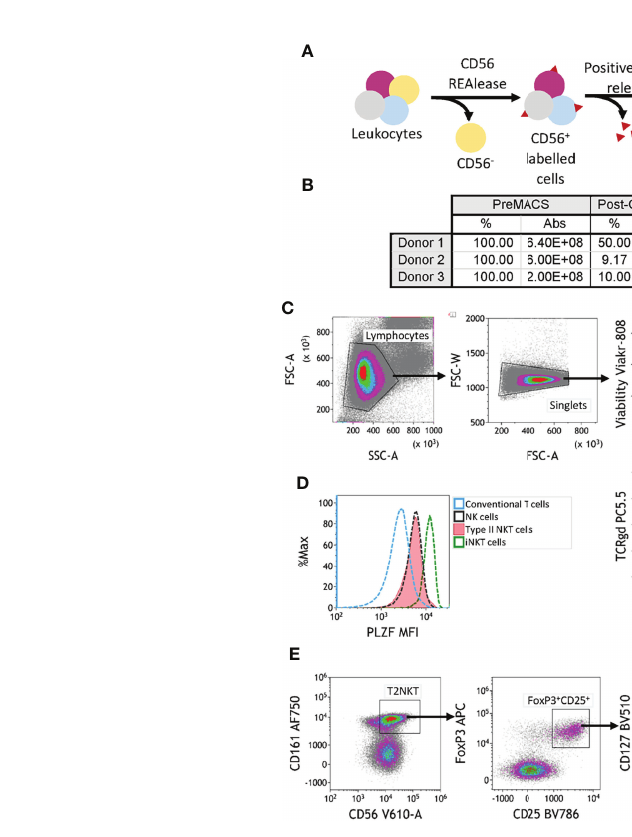
FIGURE 2 | Two-step magnetic-activated cell sorting (MACS) strategy for enrichment of human T2NKT cells. ( A ) Two-step MACS strategy consisted fi rst in a CD56 positive selection from human PBMC with CD56 REAlease microbeads. These beads were then detached from the cell surface after separation. In the second step, NKT cells were enriched using CD3 microbeads. The outcome of this procedure was a CD3 + CD56 + cell isolate enriched in NKT cells. (B) Summary table indicating the frequency of cells relative to preMACS values and absolute (Abs) cell numbers after each MACS step. (C) Gating of human leucocytes enriched for CD56 + CD3 + cells using the two-step MACS protocol. The sample was enriched for iNKT cells (2% of total CD3 + T cells) and T2NKT cells (5.3% of total CD3 + T cells). (D) Expression of the transcription regulator promyelocytic leukemia zinc fi nger (PLZF) in subsets of human lymphocytes. Differential expression of PLZF was observed between conventional T cells (blue line) and NK cells (black line). There was similar PLZF expression in T2NKT cells (red line) and NK cells, whereas iNKT cells (green line) showed higher expression. (E) A CD4 + FoxP3 + CD25 + CD127 low subpopulation of CD3 + CD56 + CD161 + TCR gd - TCRV a 7.2 - TCRV a 24 - T2NKT cells after the two-step enrichment process was identi fi ed in all 3 donors (one donor is shown as an